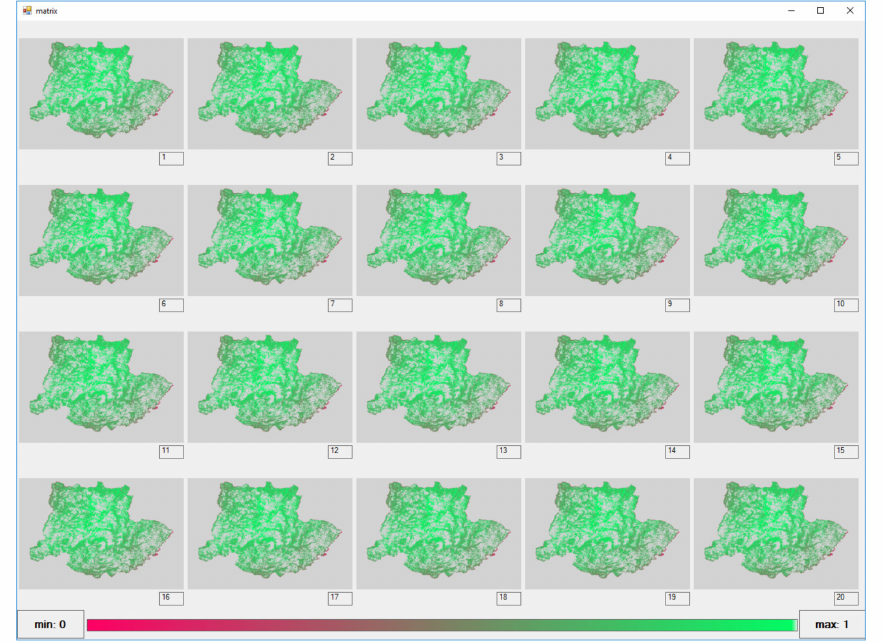
Figure A2. Value distribution (on a 0 to 1 scale) for Biomass II (B 2 ) and Sawmill I (S 1 ) over a period of 20 years (t 1 to t 20 ) in the Nordeste region, Portugal. Light green cells indicate higher suitability and light red cells lower suitability of forest units for